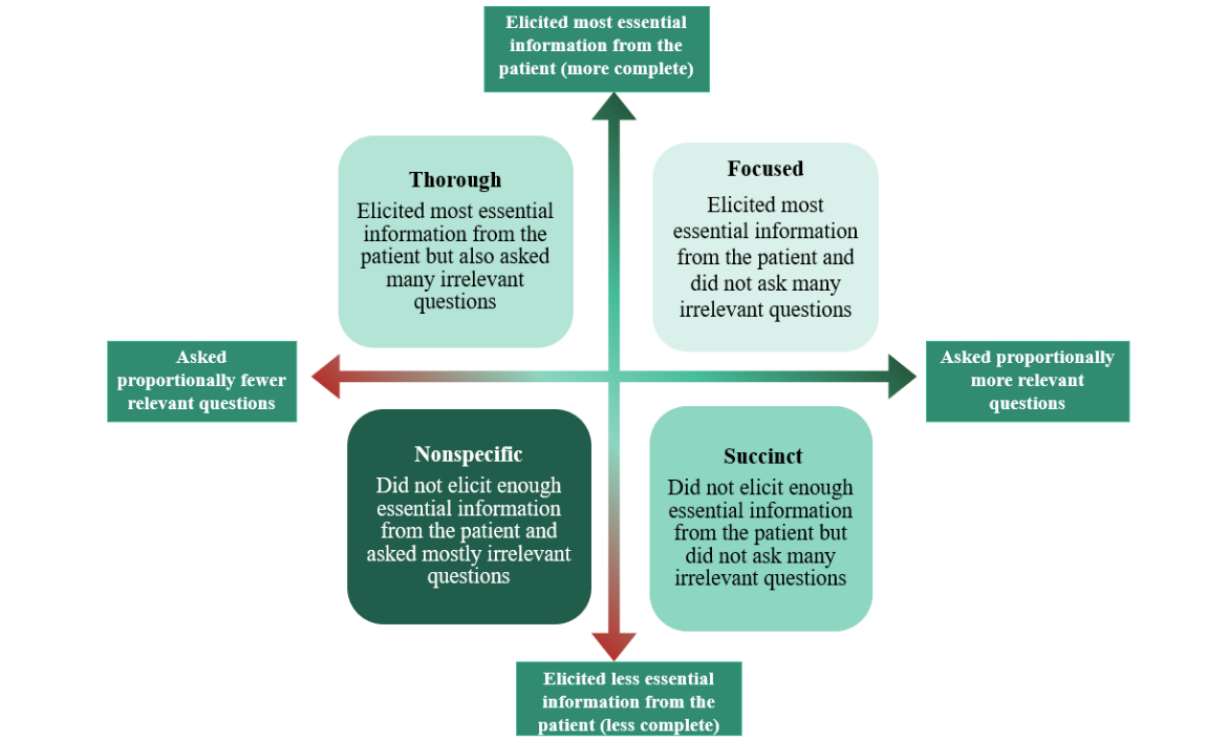
Figure 2. Characteristics of data gathering patterns based on the “Essential” and “Relevant” variables.